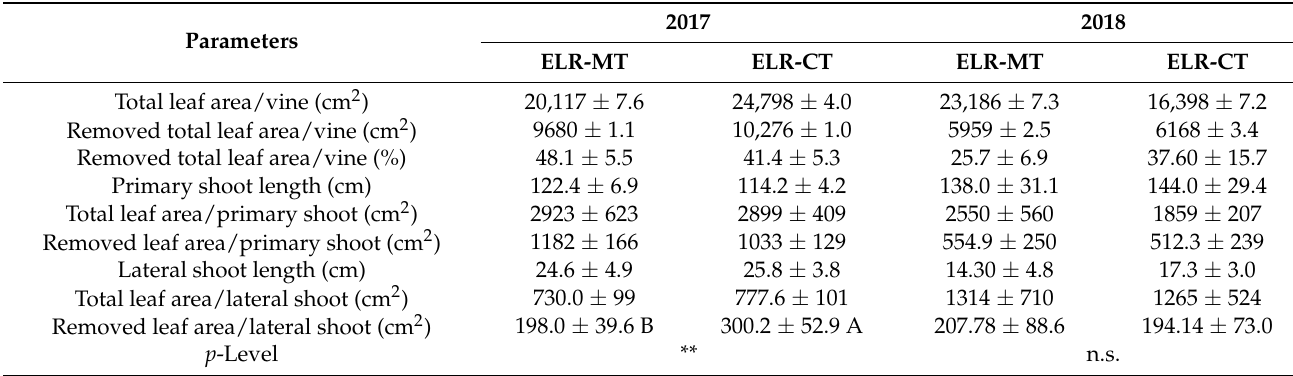
Table 1. Impact of leaf removal on primary and lateral shoot leaf area and length in 2017 and 2018 seasons in the following combination: Early Leaf Removal-Minimum Tillage (ELR-MT) and Early Leaf Removal-Conventional Tillage (ELR-CT). Data are means ± standard deviations. Means for each year indicated by different letters are significantly different ( p ≤ 0.001) based on Tukey’s HSD post hoc test within treatments.